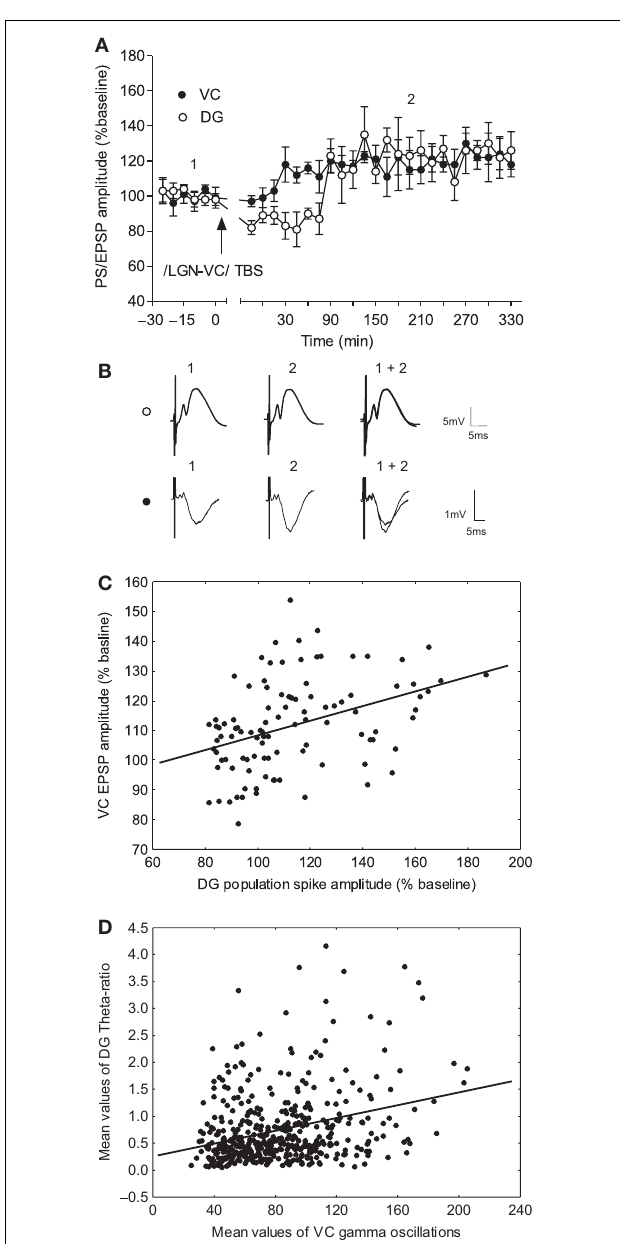
FIGURE 8 | LGN-TBS drives enhancement of the visual cortex EPSP in close correlation with the late-onset dentate gyrus E-S potentiation. (A) Comparison between visual cortex (VC) and dentate gyrus (DG) potentiation onset in response to theta-burst stimulation of LGN ( n = 5). The late–onset potentiation of the dentate gyrus population spike (PS) was preceded by an augmentation, of the same magnitude (120%), in the visual cortex fi eld response. The application of TBS to VC induced an initial short-term depression of the DG response. (B) Analog traces represent an average of 5 fi eld potentials evoked at the points marked in the upper fi gure. (C) A positive correlation between TBS-induced cortical slope enhancement and dentate E-S potentiation, was demonstrated by the comparison of the individual values from all subsequent fEPSP recordings presented in (A) . (D) Analysis of the spectral powers from the TBS experiment reveals a signifi cant correlation (Pearson, n = 4, p < 0.0001, r = 0.2812) between VC gamma oscillations and DG